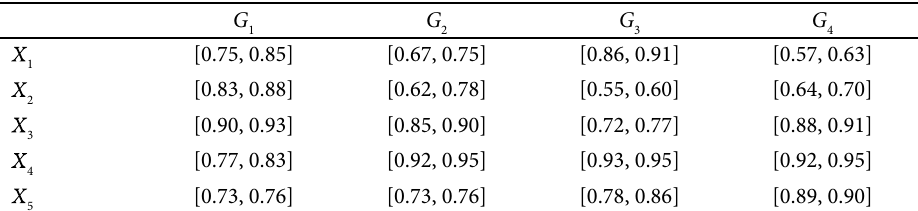
Table 2. Decision matrix 2 A